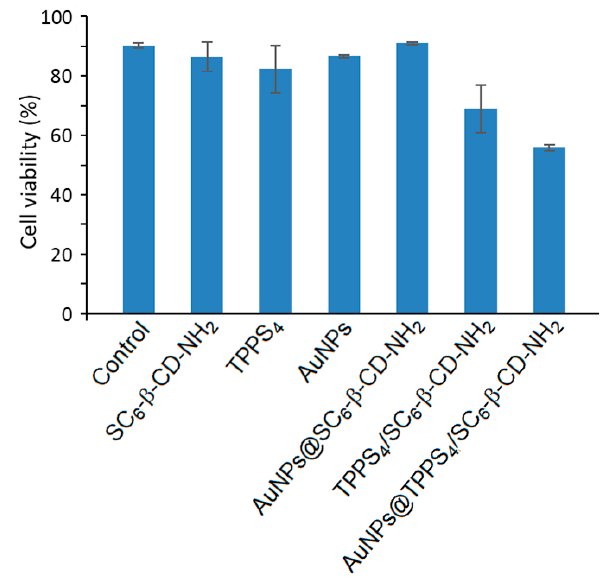
Figure 60. HeLa cell viability (MTS assay). Cells treated with SC 6 - β -CD-NH 2 , TPPS 4 , gold nanoparticles (AuNPs), AuNPs@SC 6 - β -CD-NH 2 , TPPS 4 /SC 6 - β -CD-NH 2 , and AuNPs@TPPS4/SC6- β -CD-NH 2 compared to negative control (cell untreated). Cells washed in PBS (10 mM, pH 7.4) and analyzed in the dark and after photothermal (PTT)–PDT bimodal treatment. Adapted from Trapani; Romeo; Parisi; Sciortino; Patane; Villari; Mazzaglia [197].